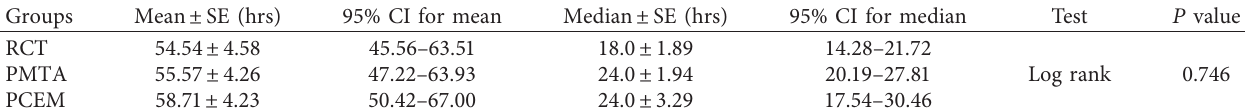
Table 6: Mean and median time (hrs) to pain-free status in the study arms.